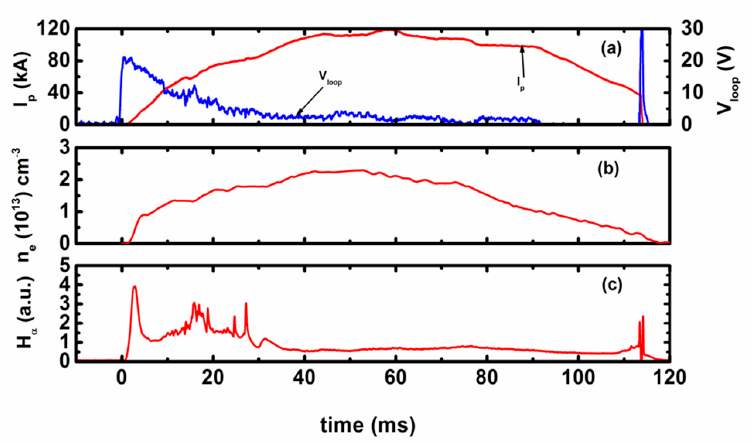
Figure 2. Temporal evolution of a typical Aditya-U plasma for shot no #33,089: ( a ) Plasma current, I p and loop voltage, V loop ; ( b ) plasma electron density, n e ; and ( c ) H α signal.